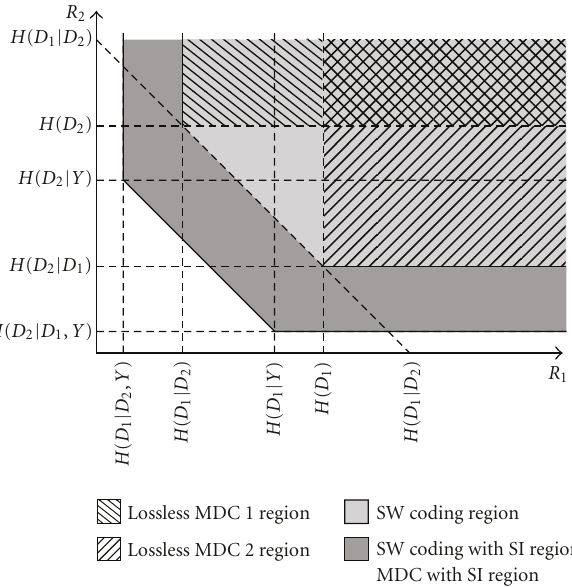
Figure 2: Achievable rate region for the two-description coding problem with